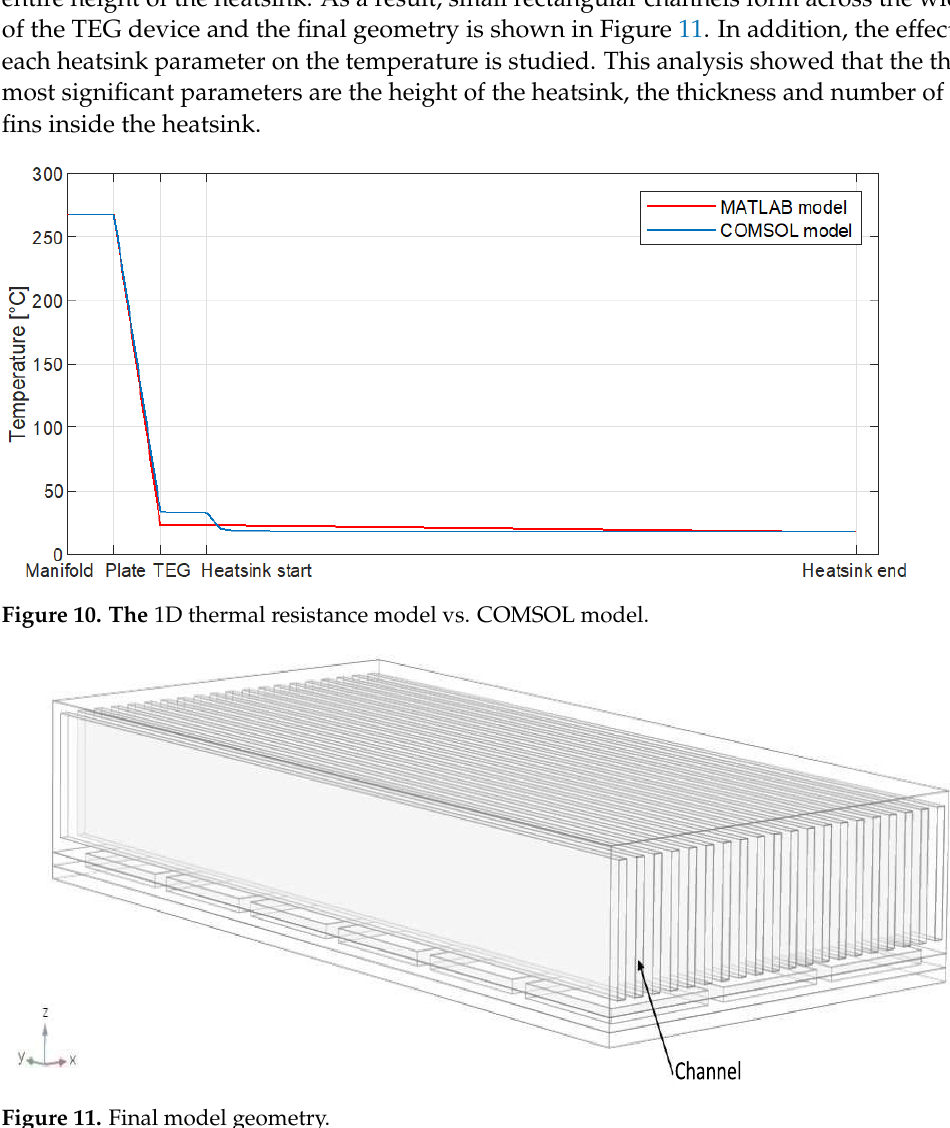
Figure 11. Final model geometry.